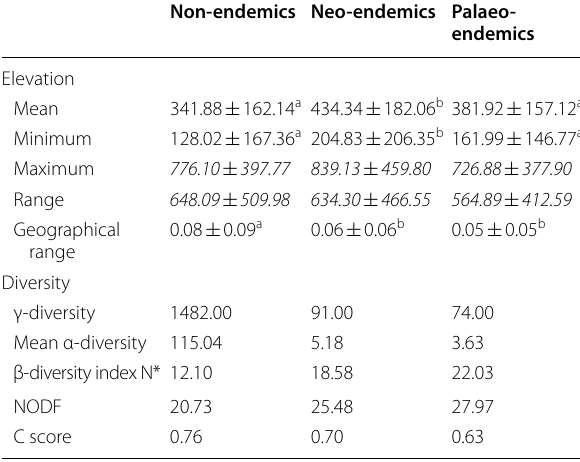
Different letters indicate significant differences in elevational and geographical range between different species categories, according to permutational one-